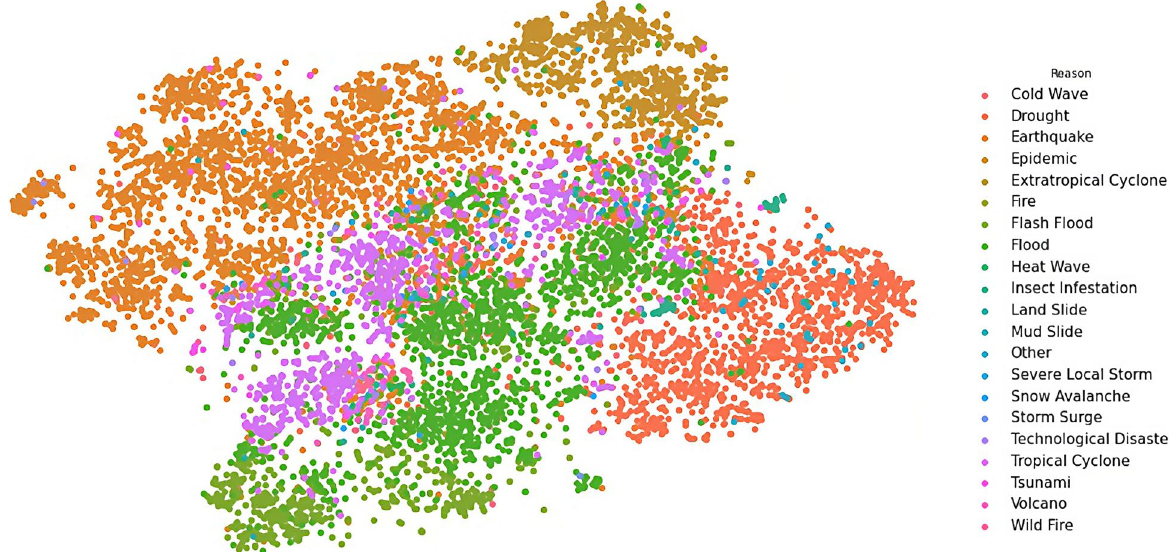
Fig. 6 Visualisation of reasons of